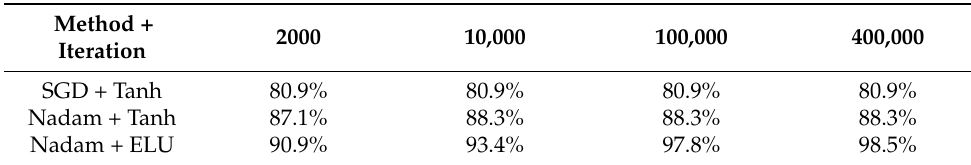
Table 5. The partial test results of three solution methods. Method + 2000 10,000 100,000 400,000 Iteration SGD + Tanh 80.9% 80.9% 80.9% 80.9% Nadam + Tanh 87.1% 88.3% 88.3% 88.3% Nadam + ELU 90.9% 93.4% 97.8% 98.5%